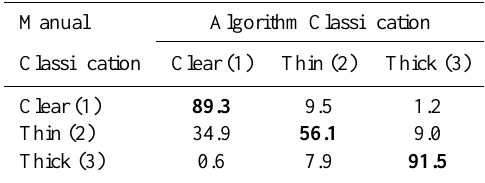
Table 7. Confusion matrix for CDOC of validation set based on fixed RBR thresholds. All values are in [%] and add up to 100% across rows. Manual Algorithm